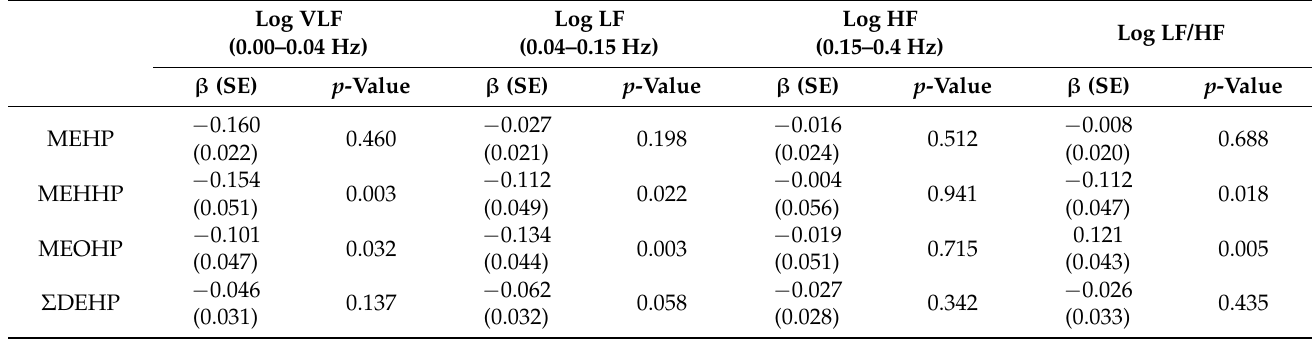
Table 3. Univariable linear regression of urinary phthalate metabolites and frequency-domain heart rate variability (HRV) analysis